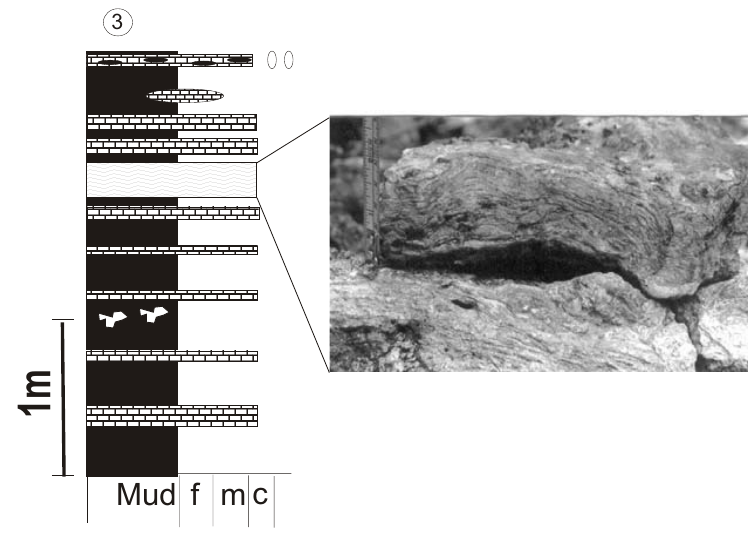
Fig. 7–Alithostratigraphicprofileillustratingthepositionofstromatolitedeposits(facies Bls, see photograph) within a succession of interbedded limestone and argillites. These were formed in a shallow subaqueous environment in marginal saline pans or lakes and mudflats. In addition to the stromatolites, this interpretation is suggested by the presence of fenestrae, tepee (indicated in the breccia horizon) and pop-corn structures. (Rule for scale is given in inches to the left and centimetre to the right). (See figure 2 for